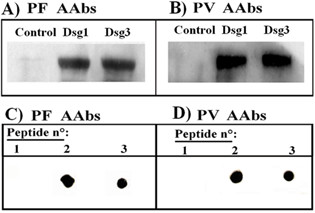
Cross-reactivity of human recombinant EC Dsg1 or EC Dsg3 proteins with PF and PV sera. Panels A and B: Western blot analysis of PF or PV serum immunoreactivity towards human recombinant EC Dsg1 or EC Dsg3 protein. Control: phosphorylase was used as a control protein. Panels C and D: Dot blot analysis of PF or PV serum immunoreactivity towards peptide: 1) Dsg3190–204LNSKIAFKIVSQEPA, 2) Dsg349–60 REWVKFAKPCRE, and 3) Dsg149–60REWIKFAAACRE.